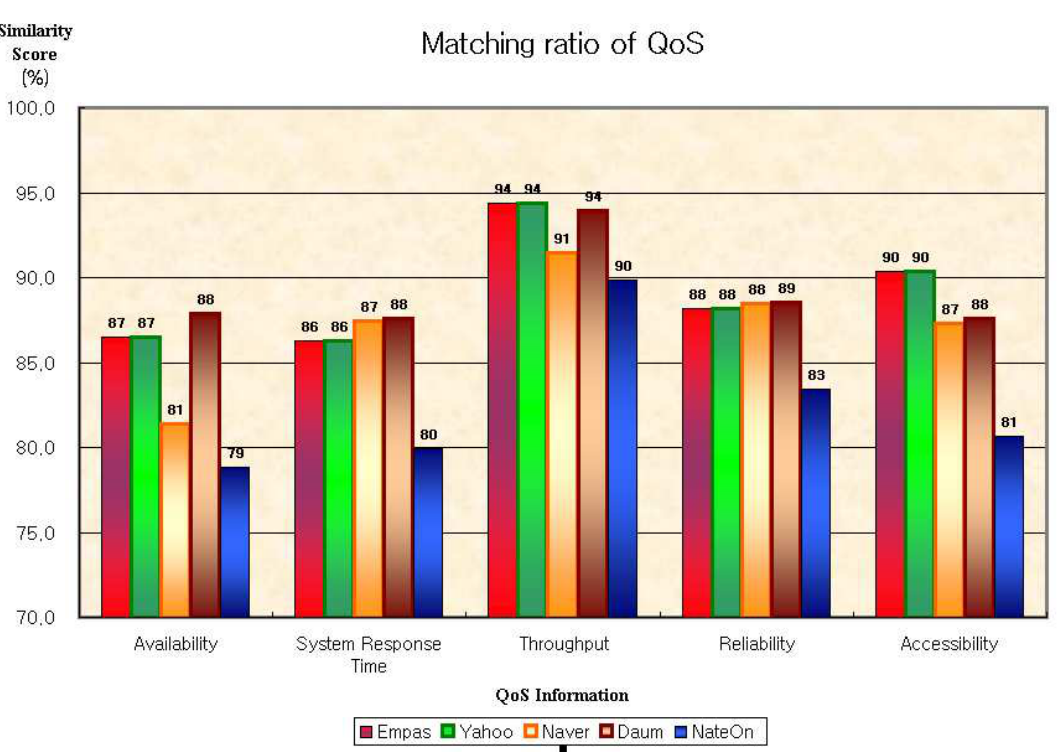
Figure 13. Matching ratio QoS(Quality of